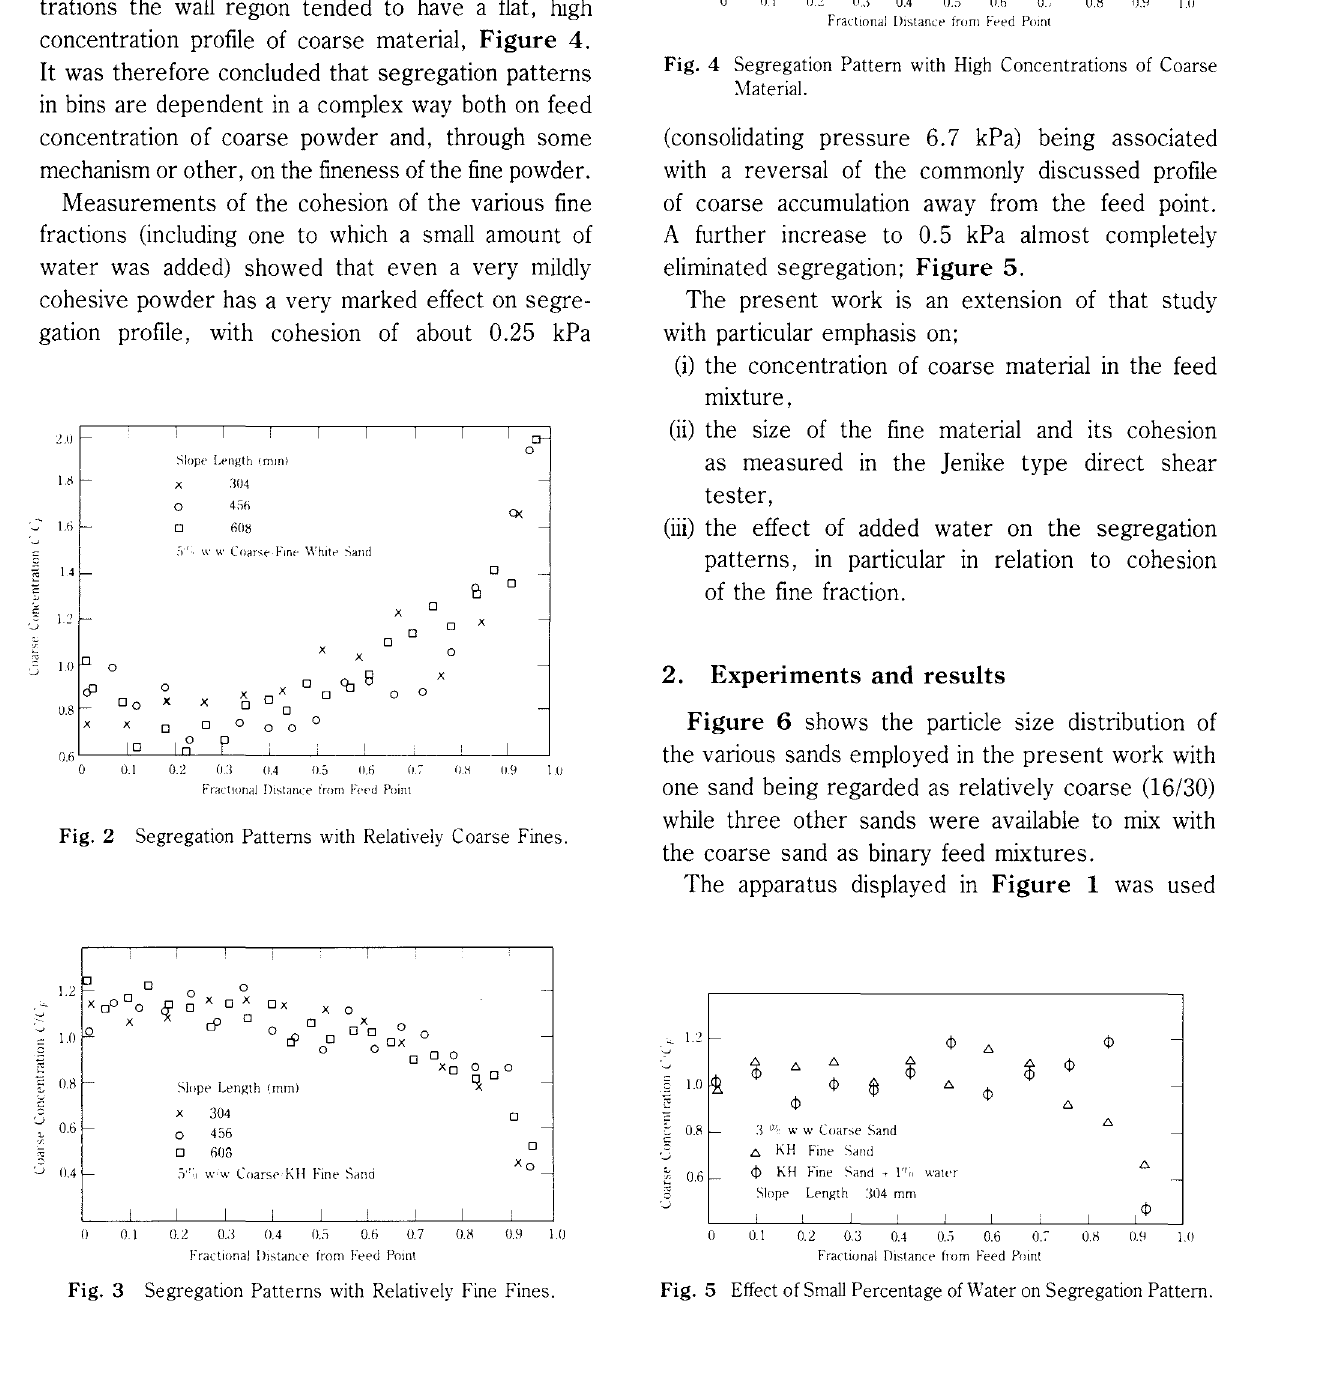
Fig. 3 Segregation Patterns with Relatively Fine Fines.